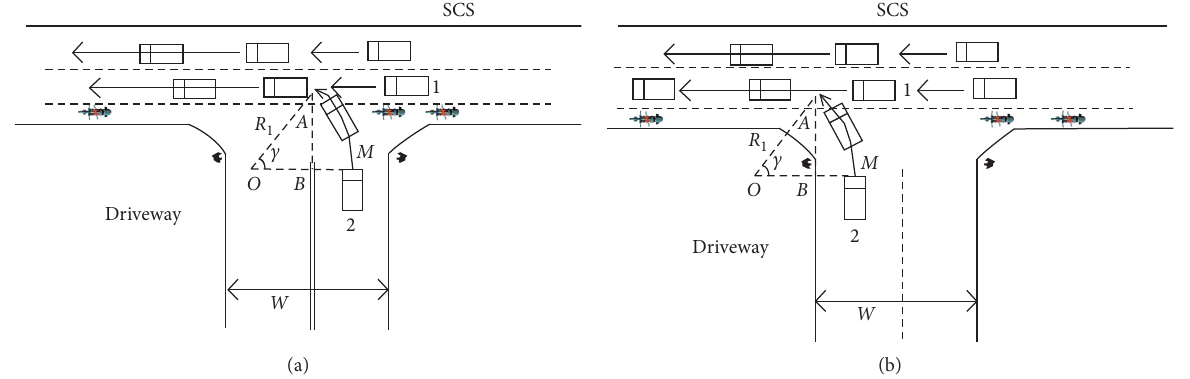
Figure 5: Left-turning on one-way SCS. (a) Right-side left-turning. (b) Left-side left-turning.